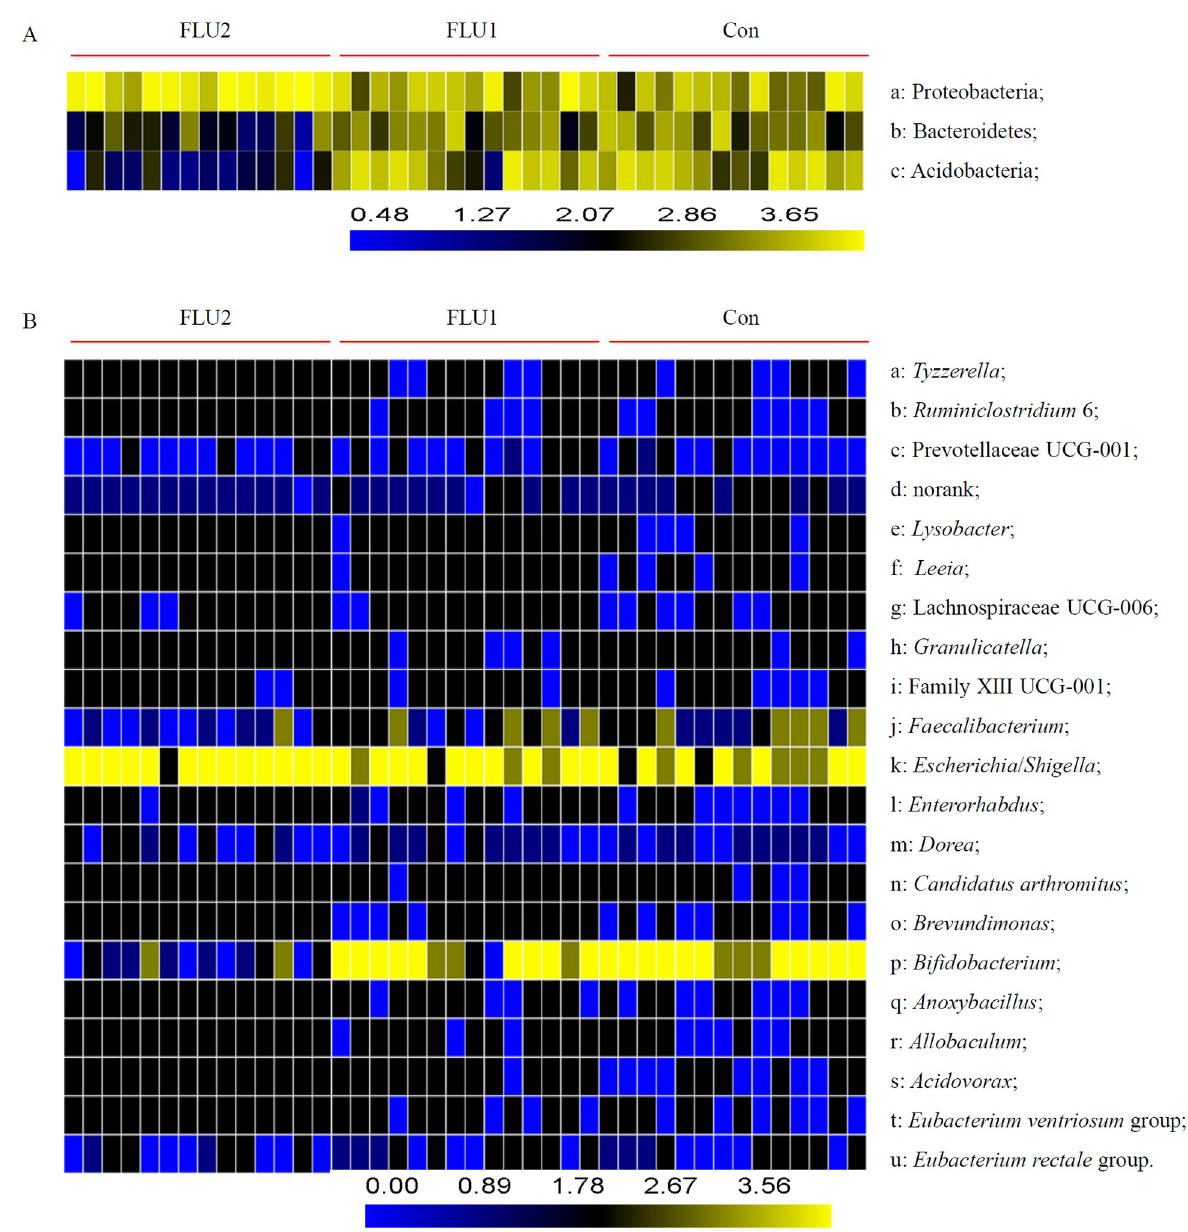
Fig 3. Relative abundance of individual gut microbiota composition at different taxonomic rank. Heatmap visualizes logarithm (base-10) of ratios (p < 0.05). A Phyla found to be statistically different among the three groups. B Genera found to be statistically different among the three